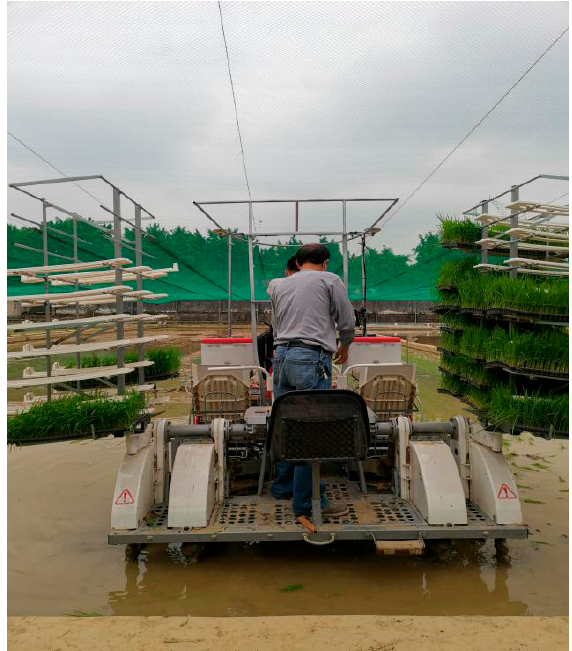
Figure 1. Pictorial view of mechanized transplanting rice machine coupled with N deep placement at the farm of South China Agricultural University, Guangzhou city, China.